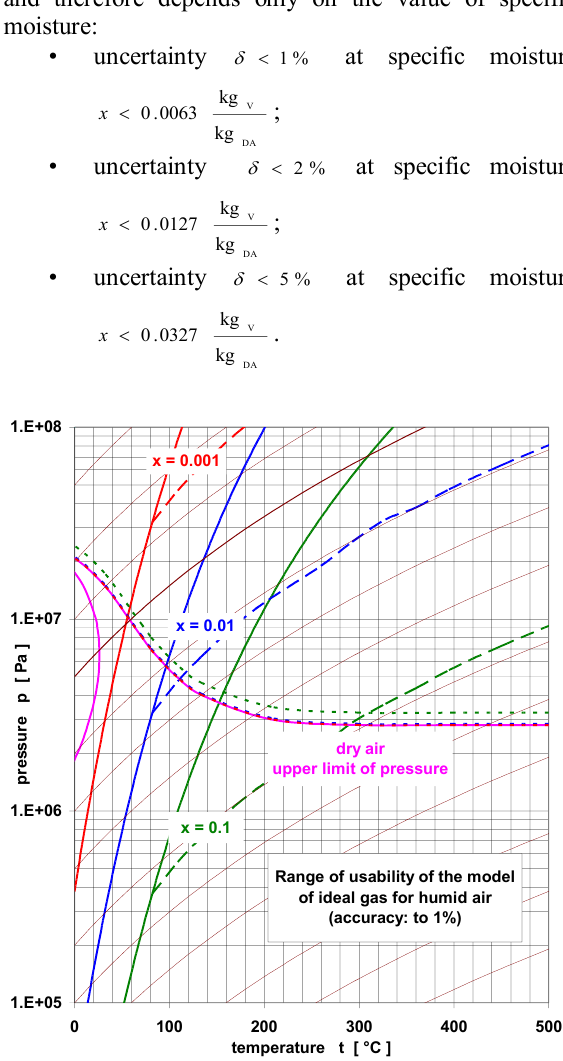
Fig. 7a. Area of usability of the ideal gas model for the calculation of properties of components of moist air at the required accuracy of the calculation to % 1 for specific moisture x of 1 . 0 , 0 1 . 0 and 0 0 1 . 0 [6]